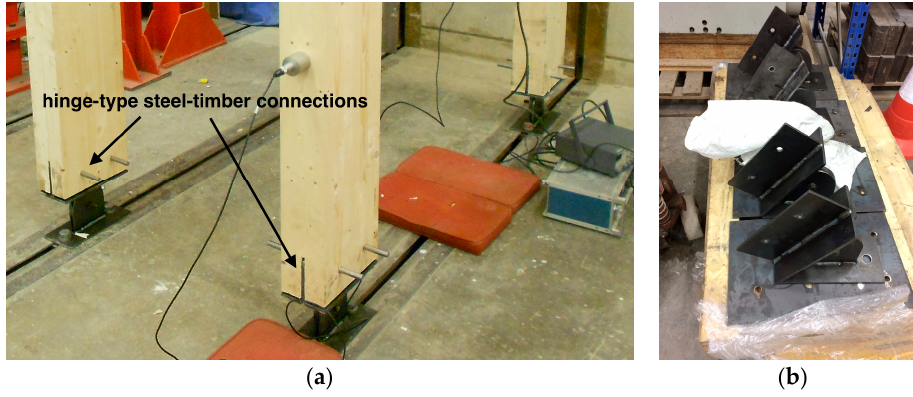
Figure 7. Details of the base connections: ( a ) detail of connections at the ground; ( b ) steel hinges.